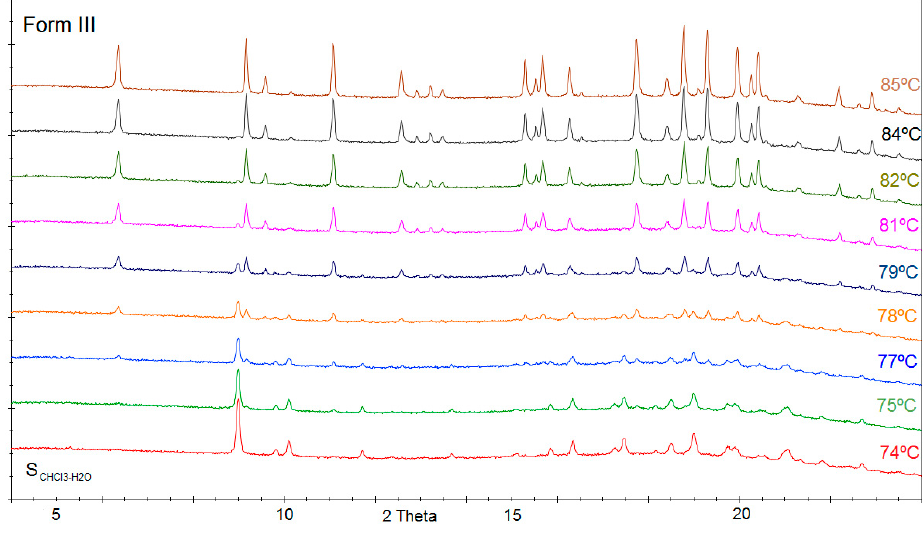
Figure 6. Temperature variable PXRD of S CHCl3-H2O showing its transformation into form III. In addition, different experiments in chloroform (vapor diffusion, slow cool crystal- lizations) were performed in order to get a single crystal of S CHCl3-H2O . Curiously, we always obtained under different conditions good quality crystals of a new solid form, as the PXRD calculated from its crystal structure solved did not match with any of the previously known forms. As shown by its crystal structure determination, this form consisted of one molecule of BL, one molecule of water and three chloroform molecules, so it was identified as the heterosolvate or mixed solvate S 3CHCl3-H2O . Its structure was solved at low temperature, and when leaving the crystal to reach r.t., the crystal collapsed, and it was impossible to measure it at ambient conditions. The presence of opaque crystals indicated that the product had transformed opaque due to pseudomorphosis. Therefore, the single crystals (which darkened immediately at r.t.) were analyzed by PXRD at r.t., and their diffractogram matched with the one of form S CHCl3-H2O . Therefore, the new form obtained at low temperature in SCXRD is a precursor of S CHCl3-H2O by losing 2 chloroform molecules from its crystal structure. Indeed, form S 3CHCl3-H2O is the one which is always obtained in chloroform solutions, and it immediately transforms into S CHCl3-H2O when removing it from the mother liquor, preventing its detailed characterization by other methods. The instability of this new identified solvate of BL means that we cannot exclude the discovery of other labile solvate forms. Highly unstable solvates are more common among small organic molecules than is generally believed [25].